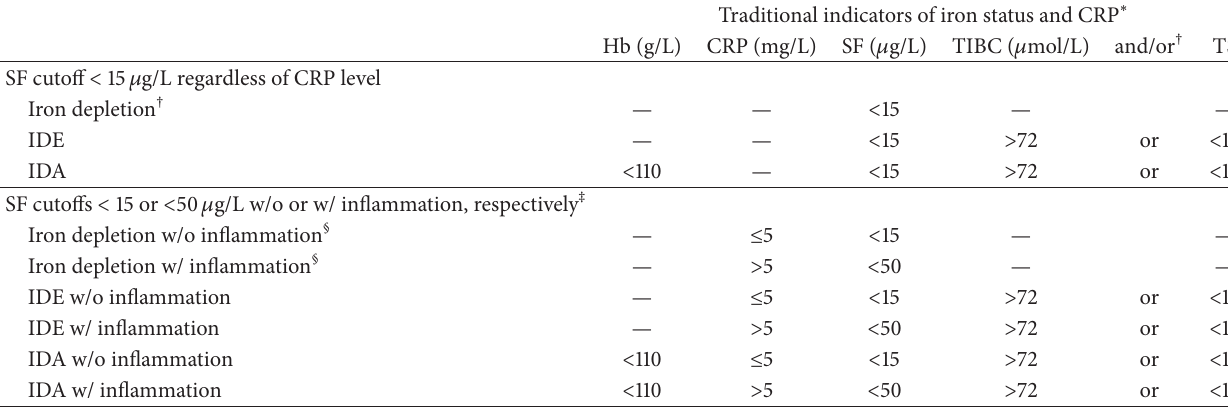
Table 1: Diagnostic criteria defining iron depletion, IDE, and IDA based on traditional indicators of iron status and CRP. Traditional indicators of iron status and CRP